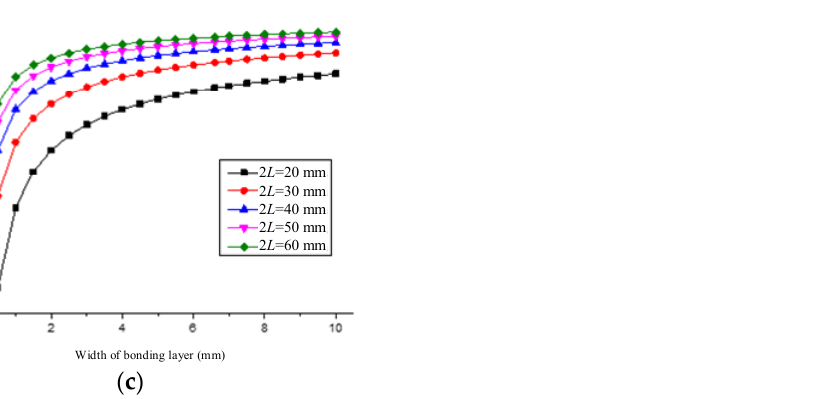
Figure 5. Sensor sensitivity and influence parameter coefficient curve. ( a ) Influence of Matrix Elastic Modulus on Sensitivity: Calculated parameters: 2 L = 40 mm, D = 1 mm, r m = 1 mm, E c = 3 GPa, μ c = 0.3; ( b ) Influence of Elastic Modulus and Poisson’s Ratio of Bonding Layer on Sensitivity: Calculated parameters: 2 L = 40 mm, D = 1 mm, r m = 1 mm, E = 40 Gpa; ( c ) Influence of adhesive layer width and fiber bonding length on sensitivity: Calculated parameters: r m = 1 mm, E = 40 GPa, E c = 3 GPa, µ c = 0.3.